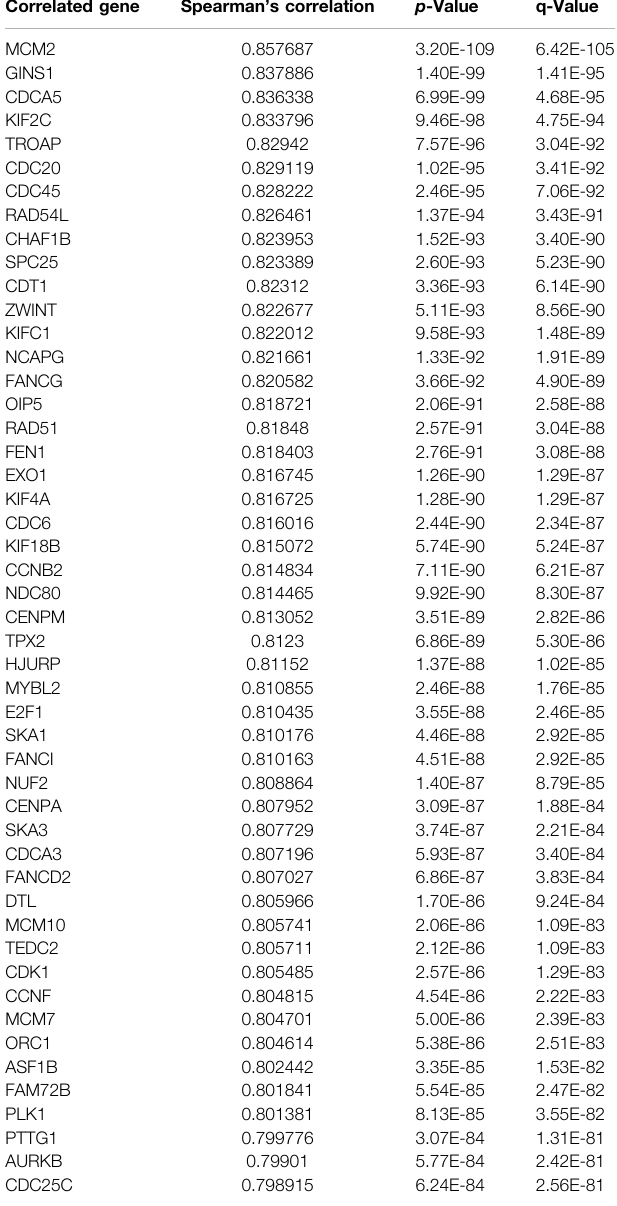
TABLE 1 | Gene positively correlated with TK1 mRNA expression in the PRAD dataset (Top 50 ranked by Spearman ’ s correlation coef fi cient). Correlated gene Spearman ’ s correlation p